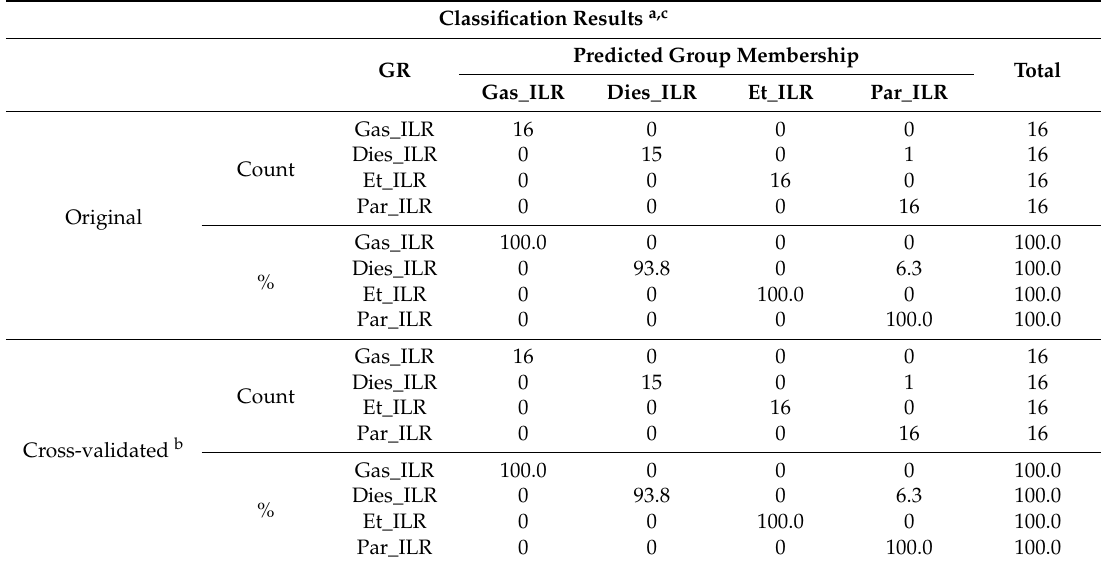
Table 1. Classification results from the LDA using the 64 samples burned with ignitable liquids (IL).